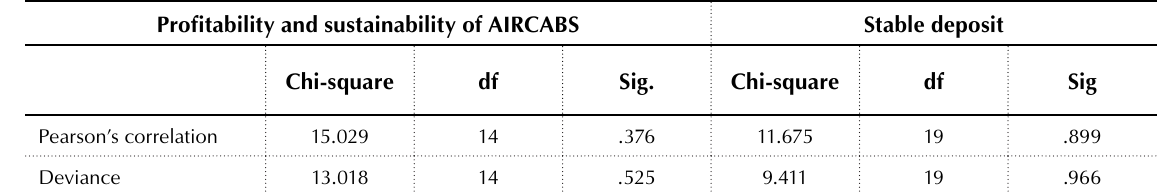
Table 24. Goodness-of-fit